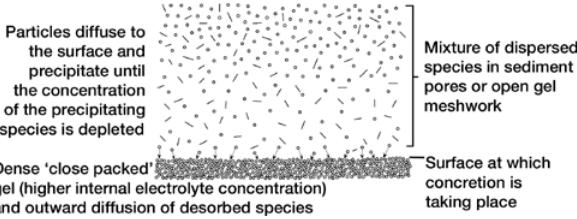
Figure 67. Diagram of the surface of a synerectic nucleus to which colloidal particles are diffusing to build up a concretionary over- growth. This internal surface within a sediment such as a mud, ooze, or slime is merely a denser ‘close packed’ gel. The active con- cretionary nucleus is synerectic, condensing under van der Waals’ attractive forces such that surface energy, internal surfaces, and adsorptive capacity are reduced. Synerectic liberation of sorbed electrolytes within the nucleus and the new overgrowth. This per- petuates the precipitation of new